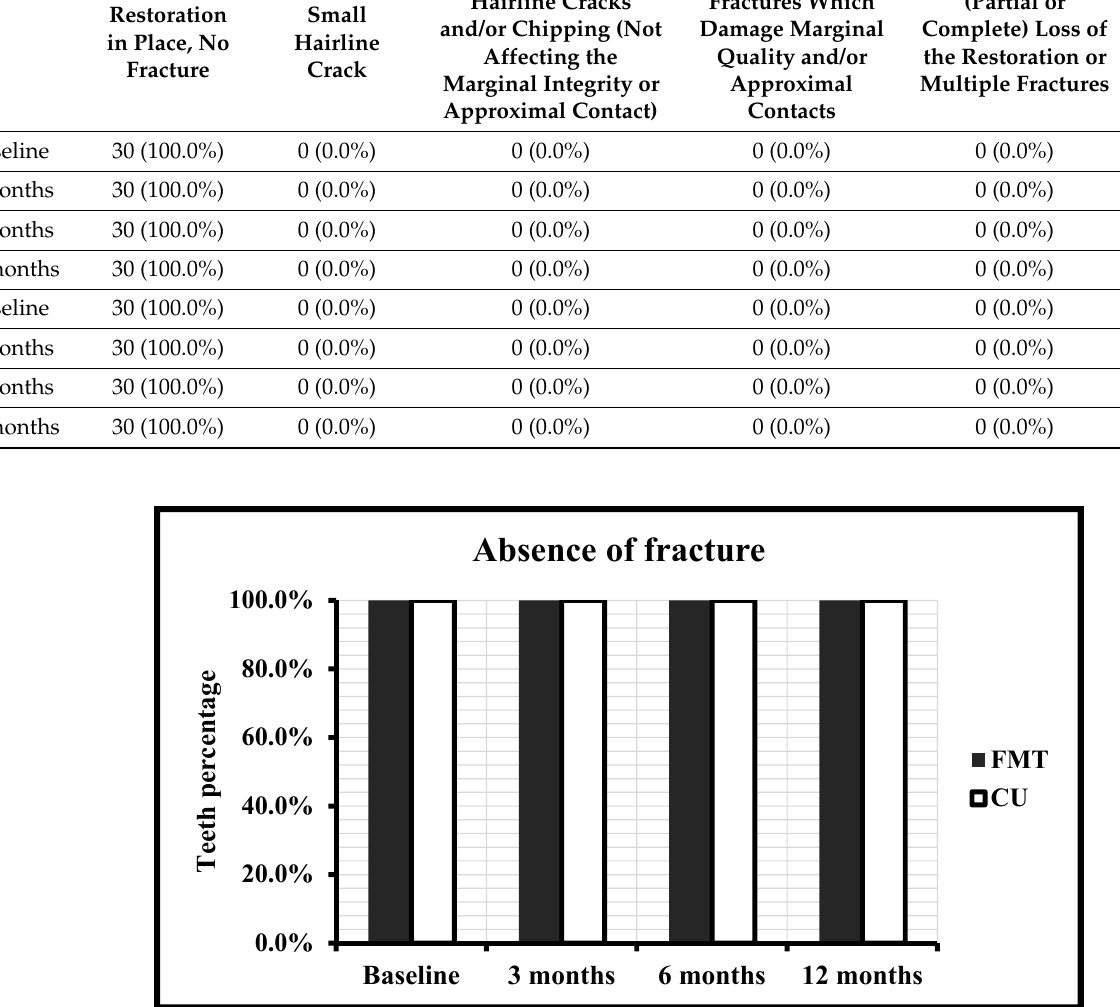
Figure 5. Absence of fracture for teeth restored with FMBT and CULT over time.